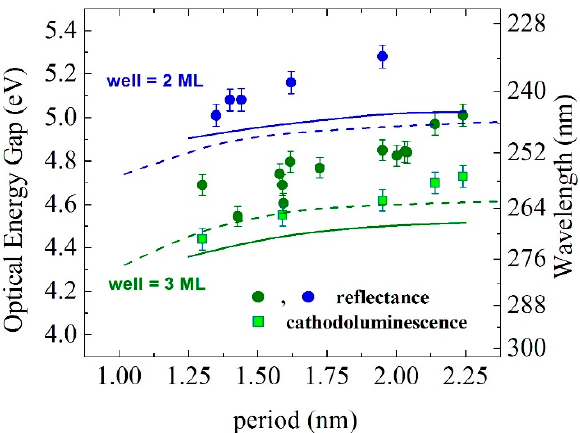
Figure 5. Experimental optical reflectance and cathodoluminescence (CL)-obtained effective bandgaps of AlN/Al 0.08 Ga 0.98 N SPSLs vs its period, grown with two nominal well thicknesses (2 and 3 monolayers (MLs), blue and green symbols, respectively) [45]. Theoretical simulations based on two approaches [46,76] are shown by continuous dashed and solid curves, respectively.